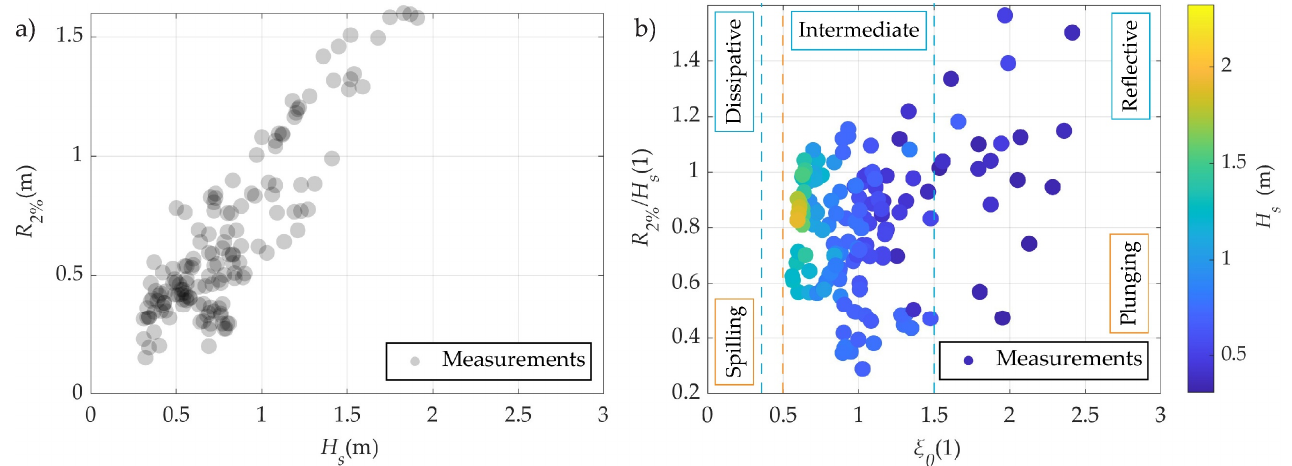
Figure 6. ( a ) wave runup on the centerline profile (profile 2 on Figure 1d) plotted against the incident offshore significant wave heights; ( b ) Relative wave runup (ratio of 2% wave runup exceedance ( R 2% ) and the significant wave height ( H s )) plotted against the Iribarren number (calculated using the offshore wave parameters); the dashed blue vertical lines separate reflective, intermediate and dissipative beach behavior, while the dashed orange vertical lines separate spilling and plunging breaker type.